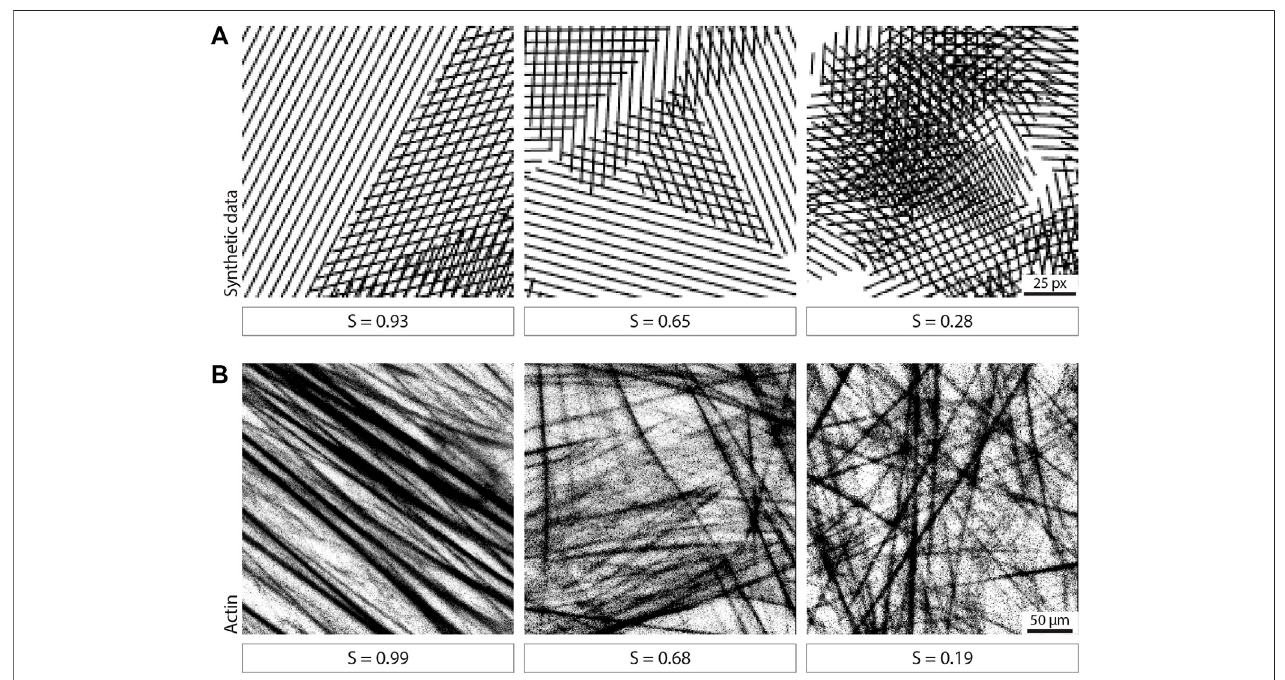
FIGURE3| Examplesofimageneighborhoodsandcorrespondingorderparameter. (A) Examplesofneighborhoodsinsimulateddatadisplayingdifferentdegrees of alignment are shown together with the calculated order parameter (window size 35 px ). Scale bar, 25 px . (B) Examples of neighborhoods in actin images displaying different degrees of alignment are shown together with the calculated order parameter (window size 100 μ m ). Scale bar, 50 μ m